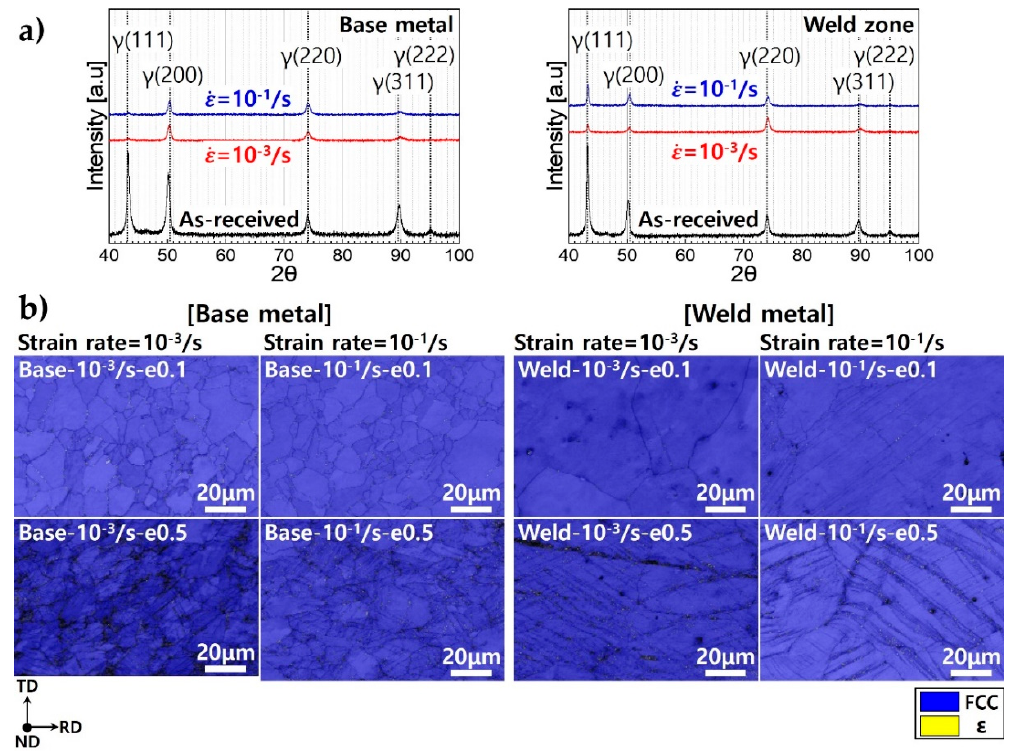
Figure 5. Phase analysis of tensile specimens after deformation. ( a ) X-ray diffraction pattern of tensile specimens deformed until fracture. ( b ) Electron-backscattered diffraction (EBSD) analysis results of phase map depending on the strain rate and deformation rate.